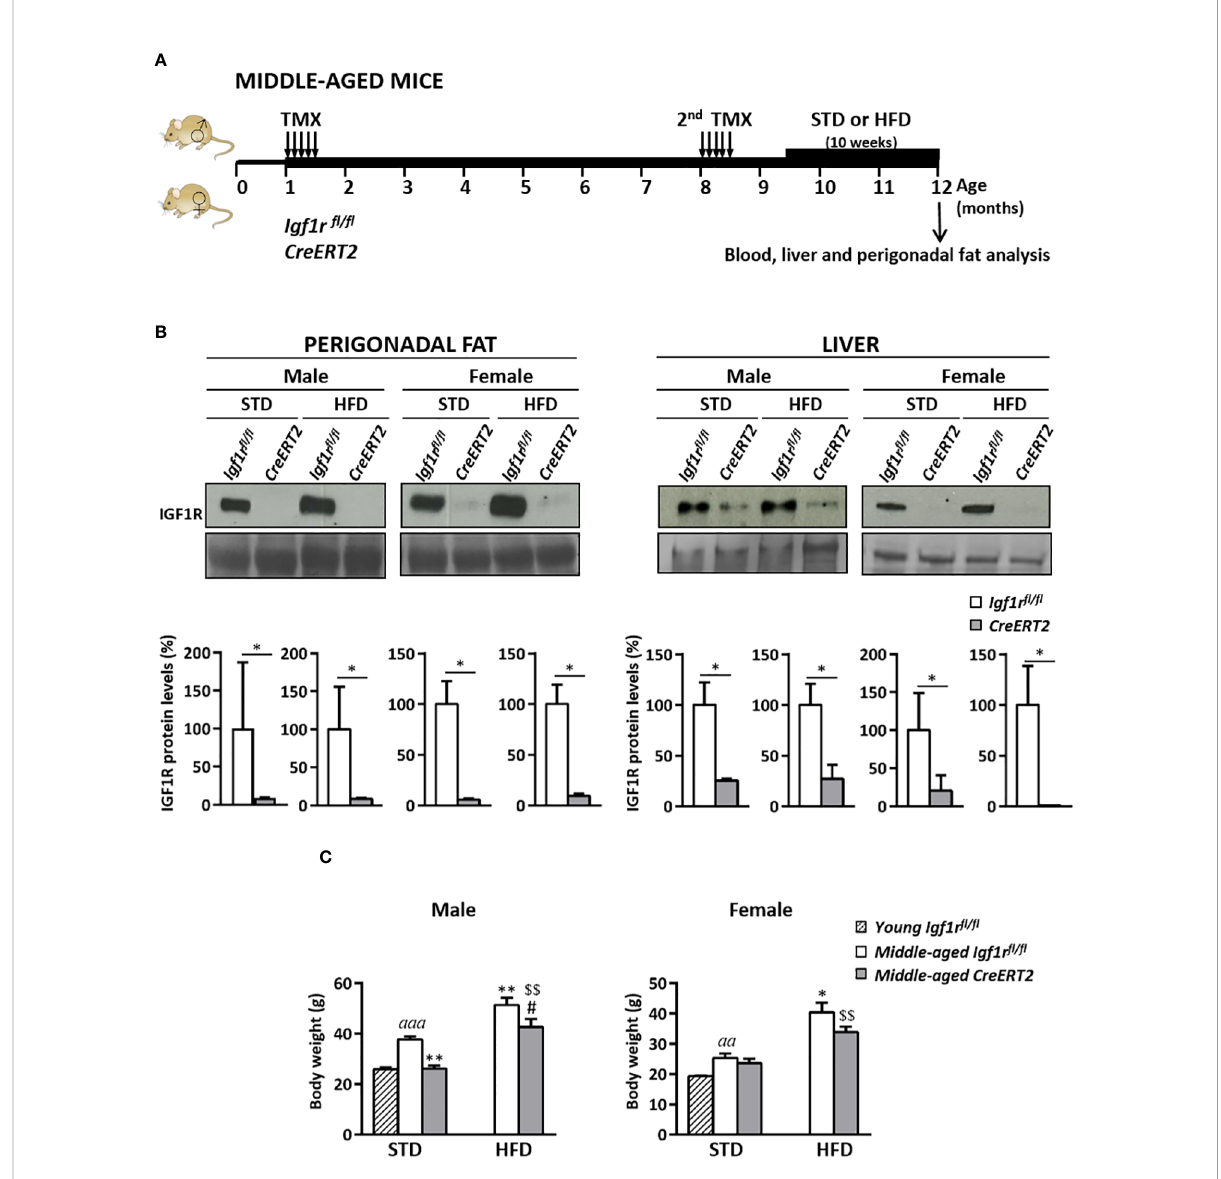
FIGURE 5 Experimental design to study the metabolic effects of IGF1R de fi ciency in middle-aged mice, IGF1R protein levels and changes in body weight in middle-aged IGF1R-de fi cient mice either on normal feeding or after a high-fat diet challenge. (A) TMX was administered daily for 5 consecutive days to Igf1r fl / fl and UBC-CreERT2; Igf1r fl / fl in two sessions, the fi rst to four-weeks-old and the second to eight-months-old animals, to generate control Igf1r fl / fl and IGF1R-de fi cient ( CreERT2) mice. Body weight was measured weekly up to their sacri fi ce on month 12. Nine and a half month-old Igf1r fl / fl and CreERT2 mice were subdivided into two different diet groups: one kept on normal standard diet (STD), and the other changed to a high-fat diet (HFD) feeding during the last 10 weeks before their sacri fi ce. (B) Representative Western blots for IGF1R protein levels and graphical representation of densitometric measurements of band intensities normalized to Ponceau staining in perigonadal fat and liver of one year-old middle-aged male and female IGF1R-de fi cient mice ( CreERT2 ) with respect to controls ( Igf1r fl / fl ), either fed with standard (STD) or challenged with HFD for the last 10 weeks (n= 2-6 mice per group). (C) Final body weight of middle-aged Igf1r fl / fl and CreERT2 mice on STD and HFD, compared to young Igf1r fl / fl control (generated as mentioned in Figure 1A). Body weight data are expressed as mean ± SEM of at